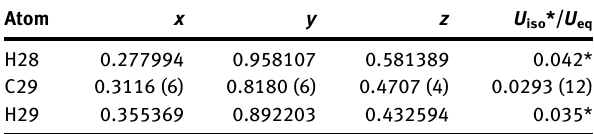
Table  : Fractional atomic coordinates and isotropic or equivalent isotropic displacement parameters (Å 